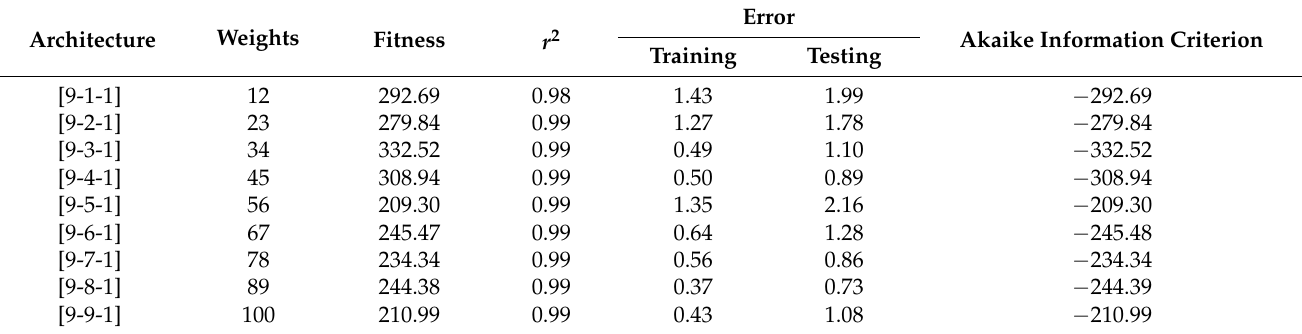
Table 3. Results of the determination of the optimal architecture of the ANN